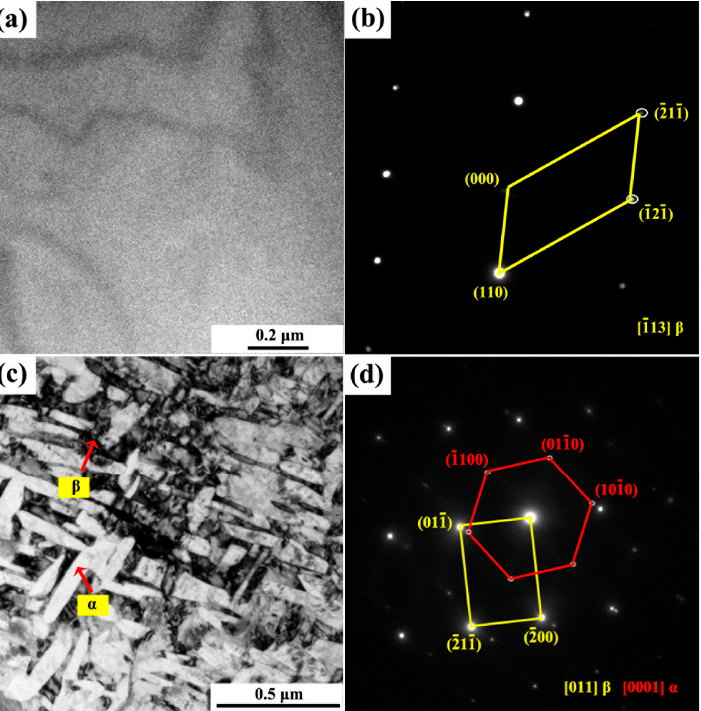
Figure 8. TEM images ( a , c ) and electron diffraction( b , d ) of Ti ‐ 6Al ‐ 10.9Cr alloy: ( a , b ) after quenching at 1100 °C, ( c , d ) after aging at 600 °C.